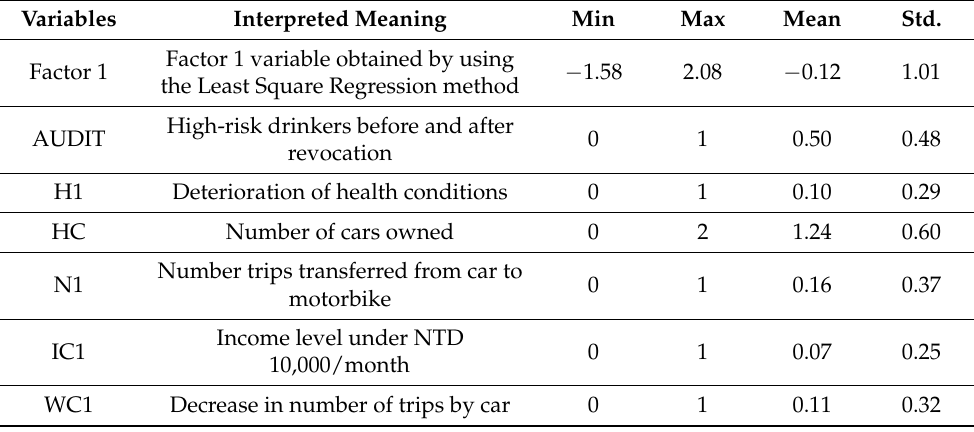
Table 9. Variables used in the double-hurdle model of car drivers’ willingness to use alcohol interlocks. Variables